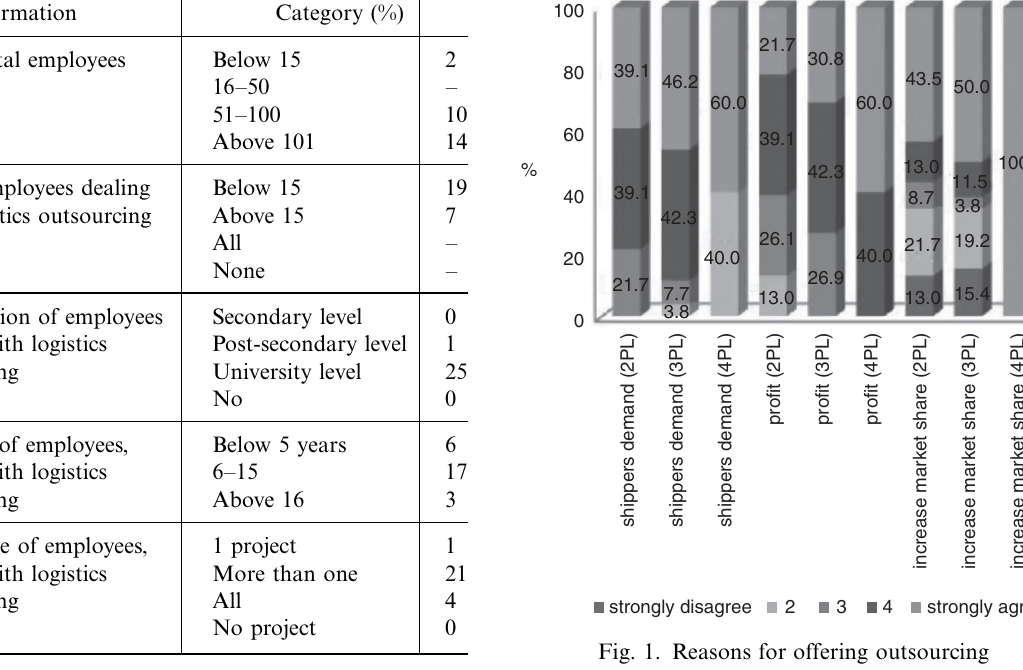
Table 1. Basic information of the sample Basic